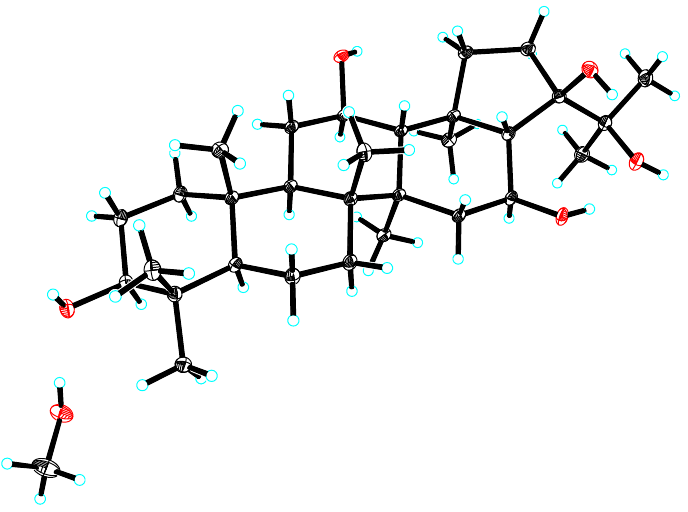
Figure 3. X-ray crystallographic structure of 1 .